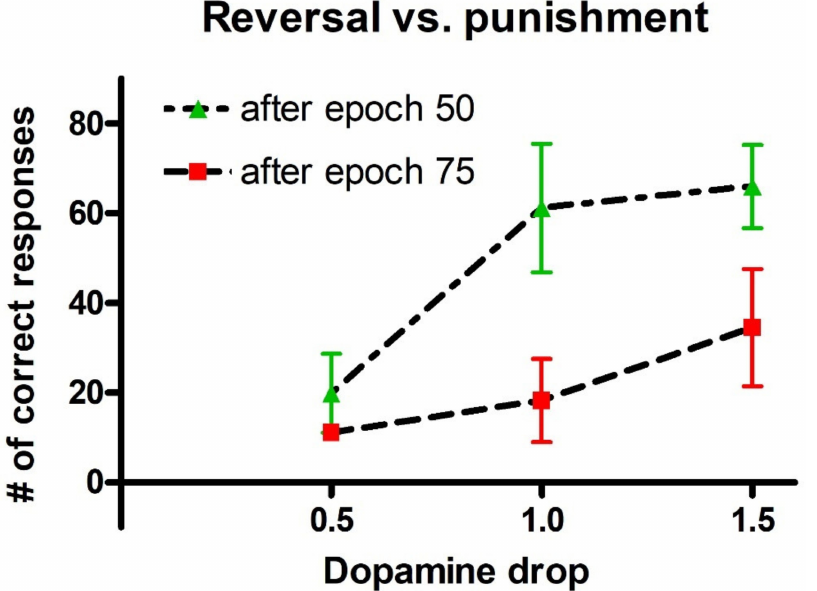
Figure 4. Effect of the dopamine phasic drop used during the reversal learning. The figure illustrates the number of correct responses achieved during the test trials after 200 epochs of reversal learning, as a function of the dopamine drop (i.e., the strength of punishment) used in the reversal training. Two cases are illustrated, when reversal learning starts after 50 epochs of previous basal training (a moderate previous learning) and after 75 epochs (a good previous learning). A dopamine drop as high as 1.0 allows a good reversal learning after 50 previous epochs. However, the reversal learning remains difficult after 75 previous training epochs, even if the dopamine drop is as high as